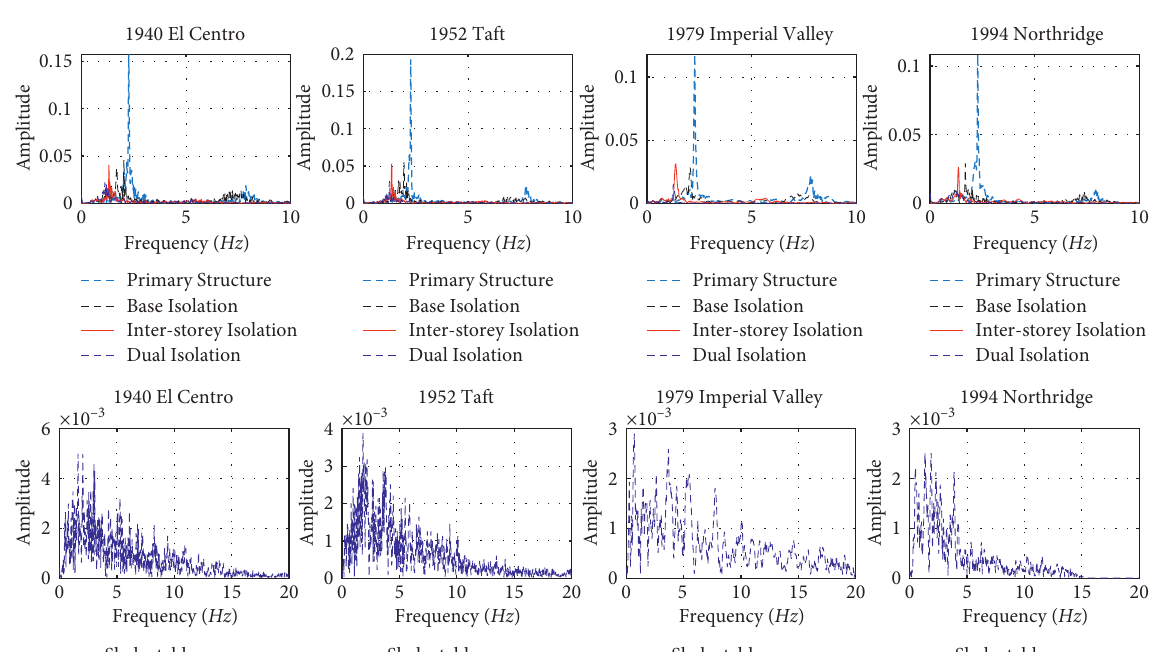
Figure 11: Fourier spectrum of top floor acceleration and shake table